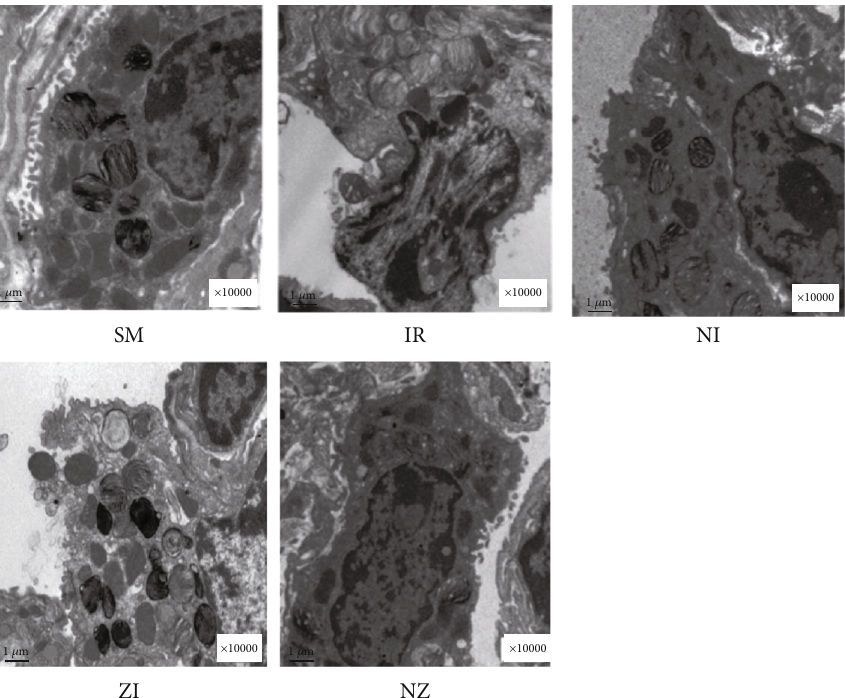
Figure 2: Ultrastructural changes in the lung tissue. The rats were randomly divided into fi ve groups. Brie fl y, the rats in the SM group received sham operation, while the left lung hilum was subjected to 1h of ischemia followed by reperfusion up to 3h in the IR group. Intraperitoneal Nec-1 (1 mg/kg) and z-VAD-fmk (3 mg/kg) were administrated before lung ischemia in NI and ZI groups, respectively, and combined administration of Nec-1 and z-VAD-fmk was given in the NZ group. After 3 h of reperfusion, lung sections were examined under electron microscope. Figure 2 is a representative photomicrograph of di ff erent groups, and images are at × 10000 magni fi cations.